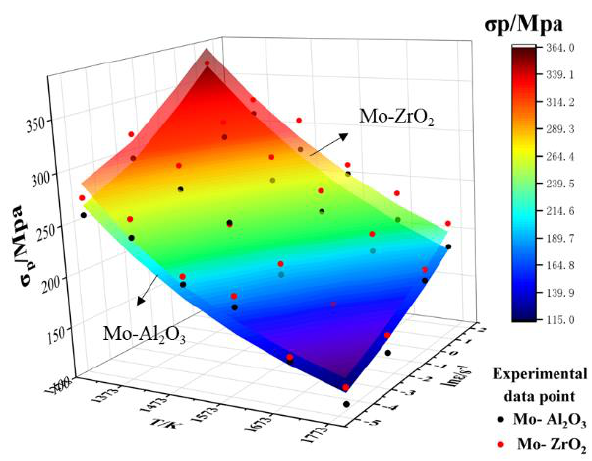
Figure 14. Comparison of Mo–1.5wt%Al 2 O 3 and Mo–1.5wt%ZrO 2 test and predicted peak flow stress values.